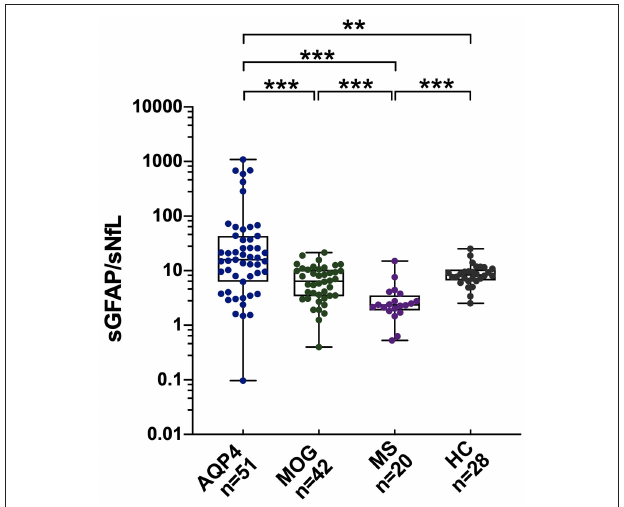
FIGURE 2 | sGFAP/sNfL ratios among the different groups. The sGFAP/sNfL ratios were compared among all the samples from patients with AQP4-antibody-positive NMOSD, MOGAD, and RRMS, as well as from HCs. Boxes depict the median and interquartile range (IQR), with the median represented by the line in the center, and whiskers extending from minimum to maximum values. sNfL, serum neurofilament light; sGFAP, serum glial fibrillary acidic protein; HC, healthy control; AQP4, aquaporin 4; NMOSD, neuromyelitis optica spectrum disorders; MOGAD, myelin oligodendrocyte glycoprotein-antibody-associated diseases; RRMS, relapsing-remitting multiple sclerosis. ** p < 0.01, and *** p < 0.001. In the figure, AQP4 stands for AQP4-antibody-positive NMOSD; MOG stands for